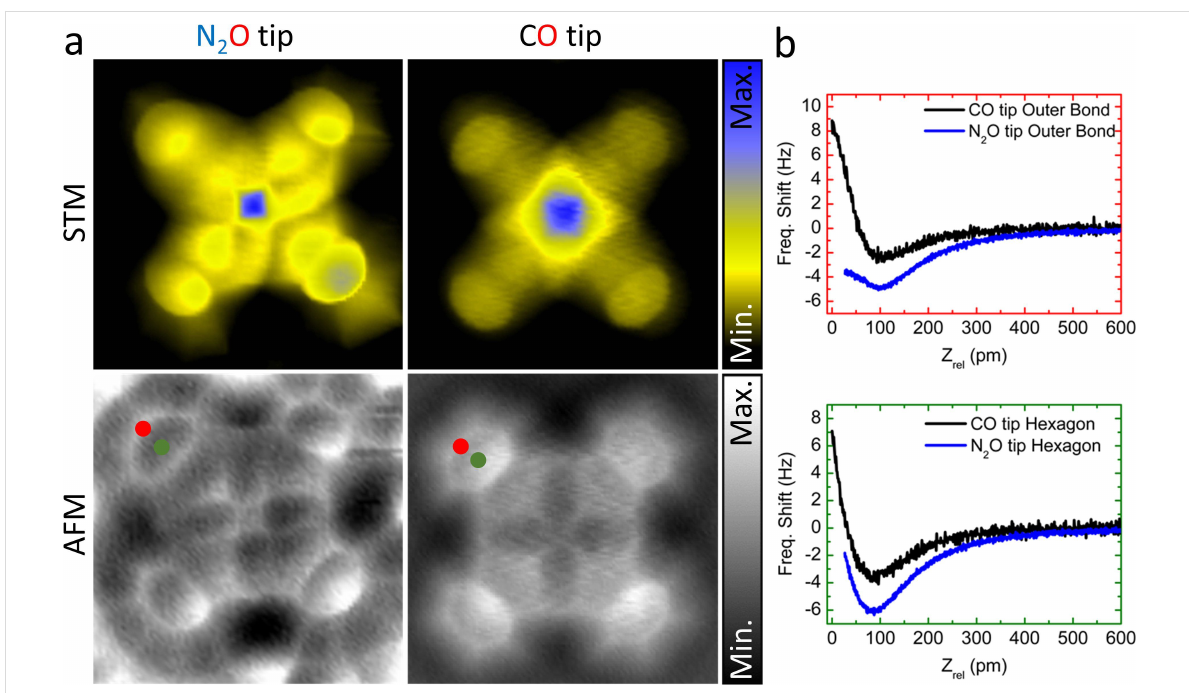
Figure 5: (a) STM and AFM constant-height images of the FePc on Au(111) (1.7 × 1.7 nm 2 , V b = 3 mV) obtained with two different tip terminations, N 2 O and CO. The STM scale for N 2 O ranges from 0.6 to 43 pA and for CO from 3.8 to 410 pA. The AFM gray scale for N 2 O ranges from − 23 to − 12 Hz and for CO from − 12 to 10 Hz. (b) Site-specific Δ f spectroscopy obtained with N 2 O and CO tip terminations above the outer C–C bonds (red dot) and the centers (green dot) of the peripheral benzene rings of the molecule.